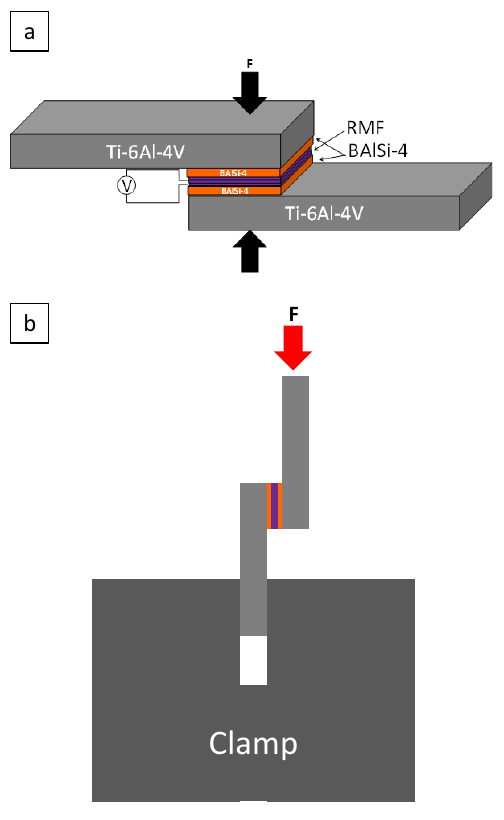
Figure 1. ( a ) Schematic of the configuration used in brazing experiments. ( b ) Schematic of lab shear testing.